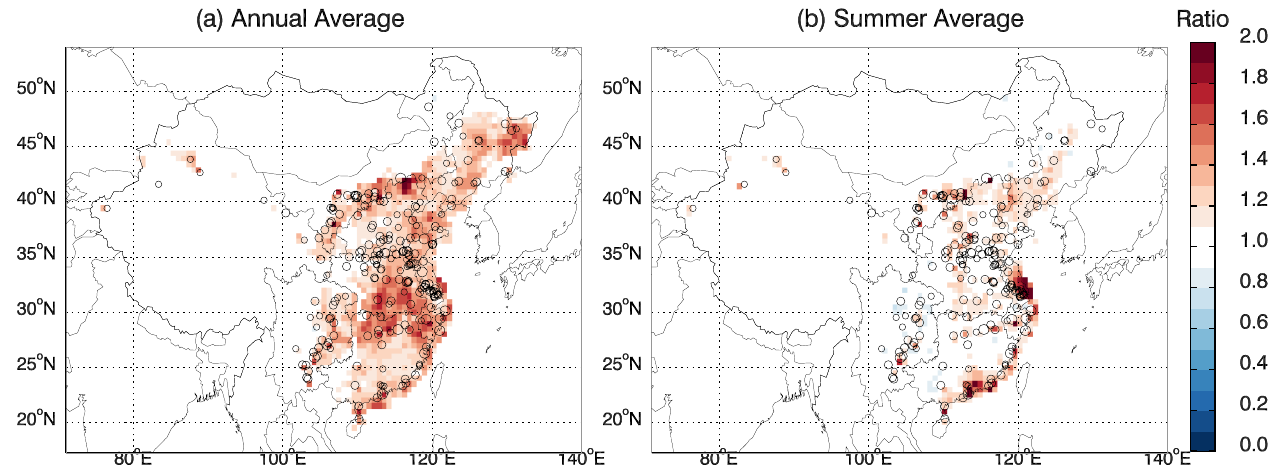
Fig. 8. Ratios of GEOS-Chem modeled tropospheric NO 2 columns between 2007 and 2005 using (a) annual averages and (b) summer averages. The cartography is same as Fig.